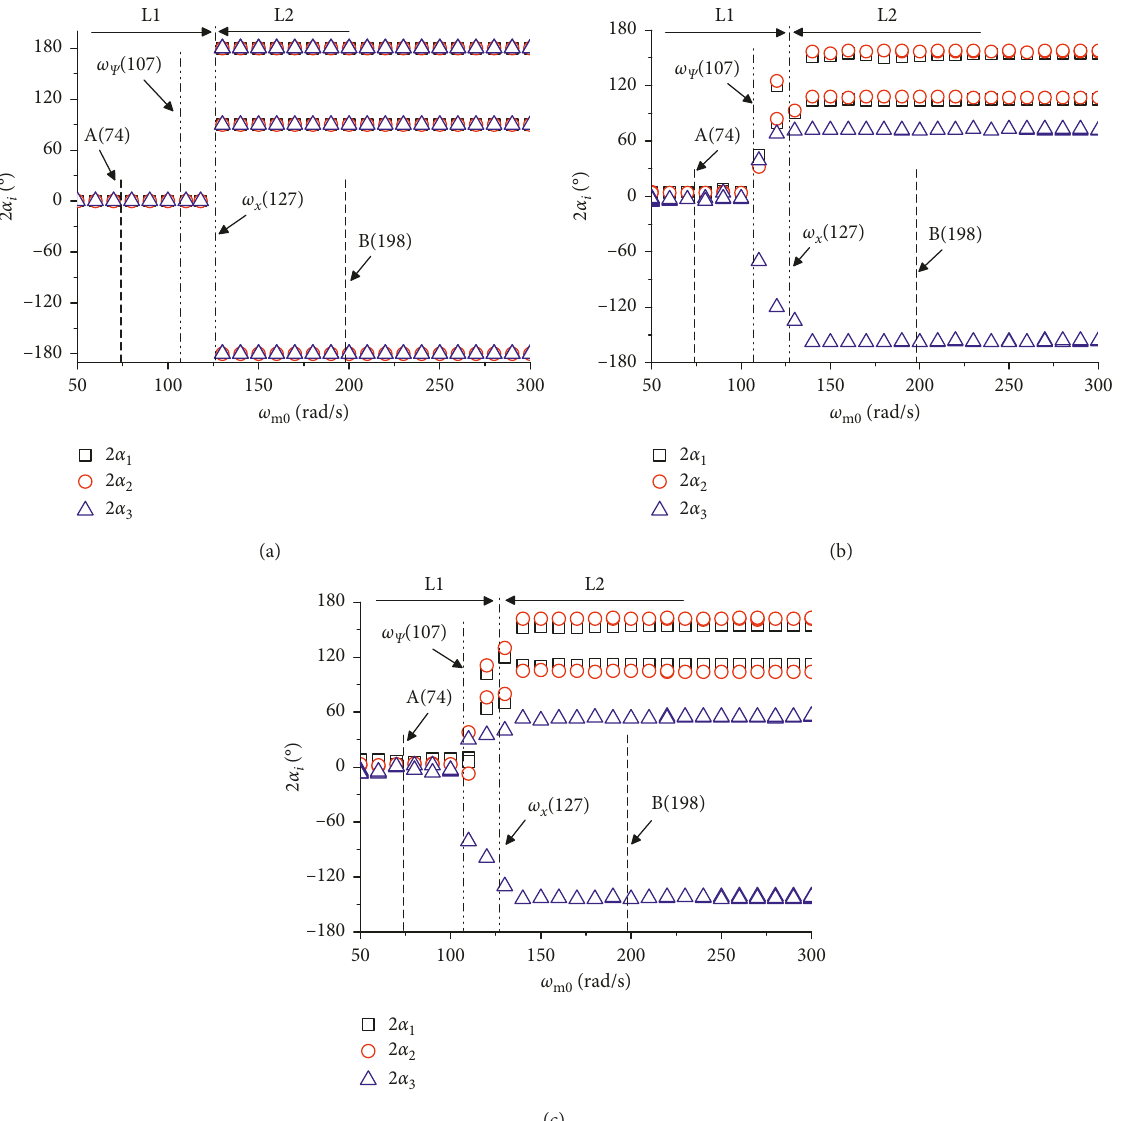
Figure 4: Stable difference-values of phase in the different η (c) η 1